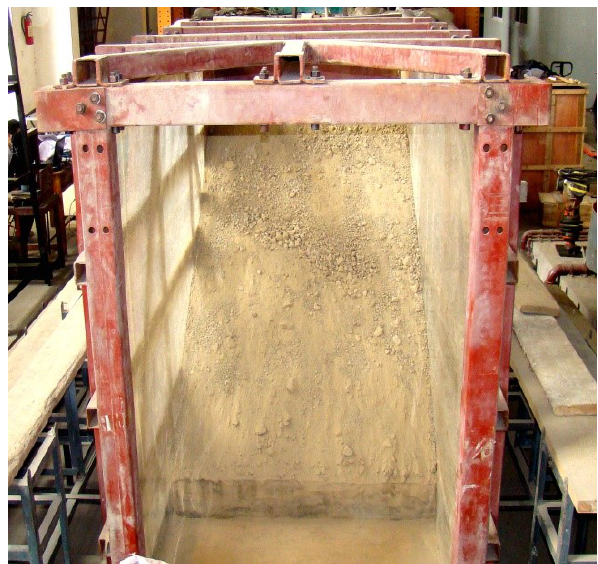
Figure 8. Photo of the sandpile model.